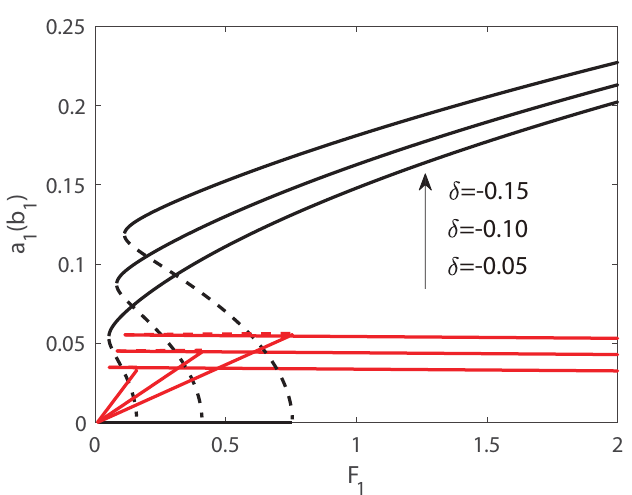
Figure 10. Amplitudes of response as functions of the excitation F 1 for different δ .